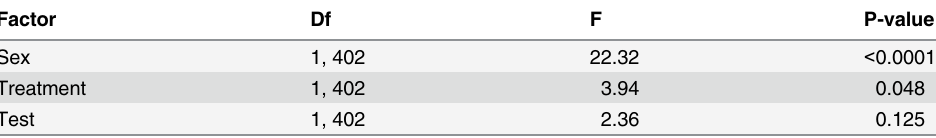
Table 2. Results from the GLM with Gaussian distribution. Results based on the latency data associated with the single stimulus tests in the compound conditioning experiment. All non-significant interactions were removed ( α >